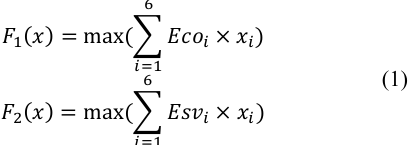
Figure 1. Location of the study area.